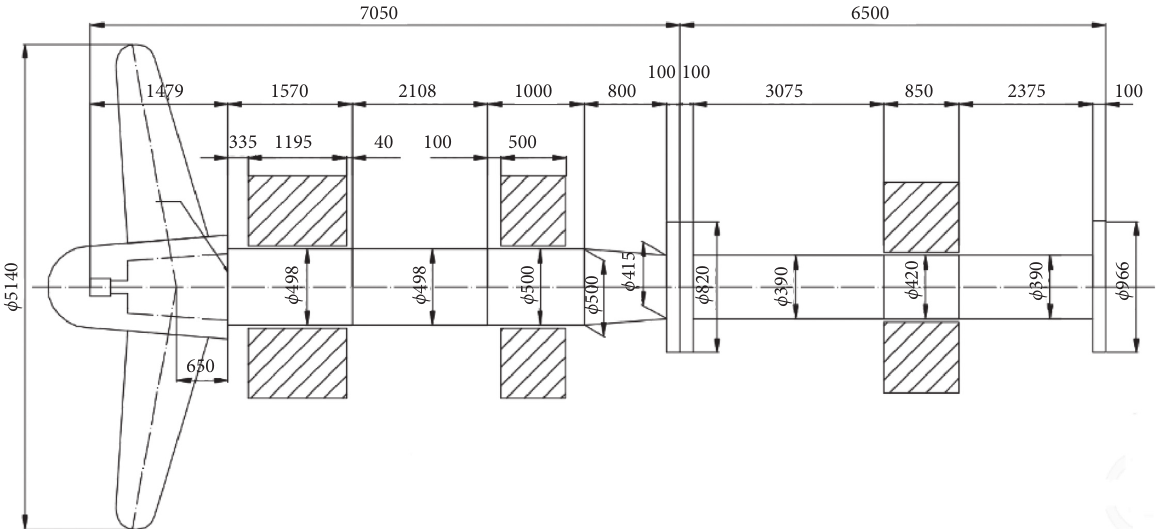
Figure 3: The diagram of a ship propulsion